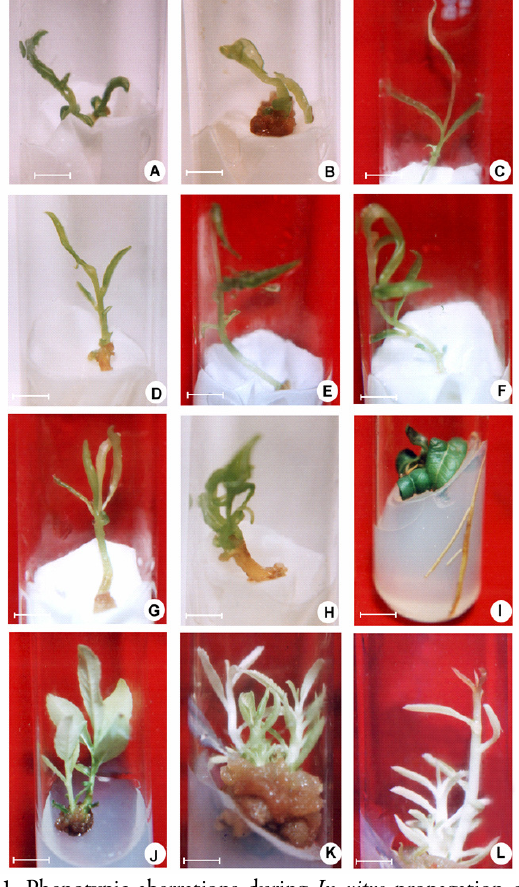
Fig. 1. Phenotypic aberrations during In vitro propagation of